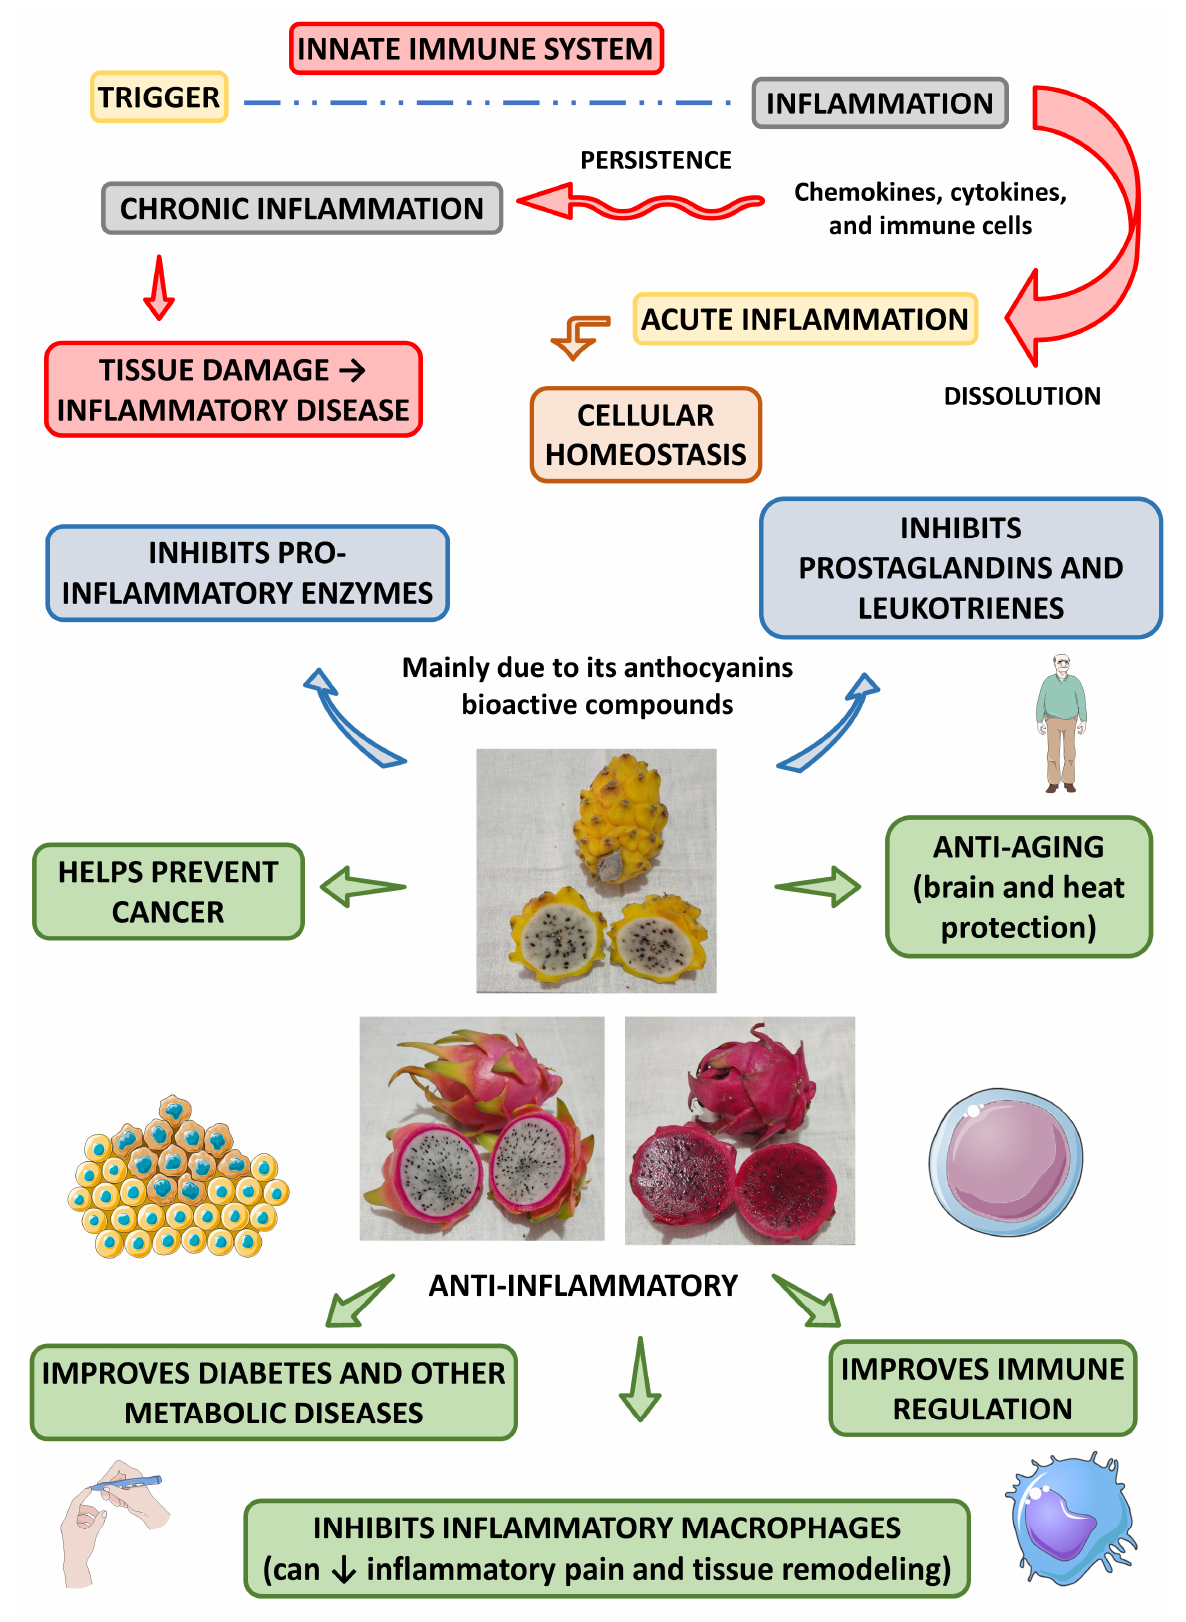
Figure 5. Main anti-inflammatory effects of Hylocereus species and their health effects. ↓ Figure 5. Main anti ‐ inflammatory effects of Hylocereus species and their health effects. ↑ —increase; ↓ —decrease.